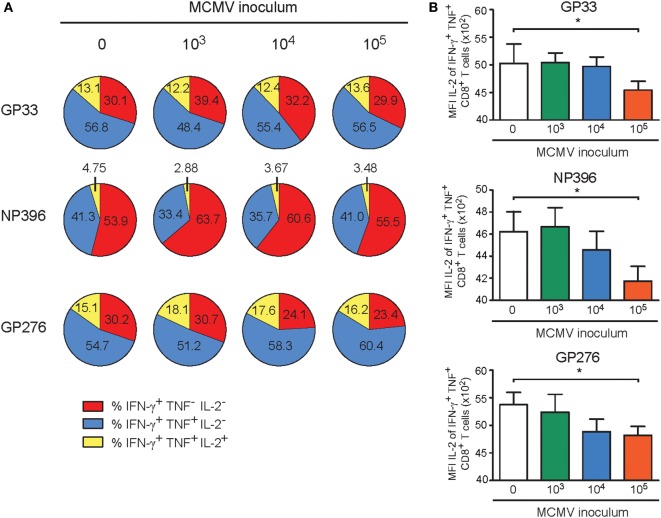
High-dose CMV infection impairs the autocrine IL-2 production of heterologous viral-specific T cells. Wild-type (WT) mice were kept uninfected or infected with 103, 104, or 105 PFU mouse CMV (MCMV)-Smith, and at day 400 post-infection 8 mice per group were challenged with 2 × 105 PFU lymphocytic choriomeningitis virus (LCMV)-Armstrong. At day 8 post LCMV infection, mice were analyzed and compared with uninfected littermate controls. (A) The cytokine polyfunctionality of splenic CD8+ T cells was determined after peptide restimulation. Pie charts depict the percentages of the single (IFN-γ), double (IFN-γ/TNF), and triple (IFN-γ/TNF/IL-2) cytokine producers of each antigen-specific T cell population upon peptide stimulation. (B) MFI of IL-2 expression of LCMV-specific CD8+ T cells. All data represents mean values + SEM (n = 8 per group, *P < 0.05). Data were pooled from two independent experiments.